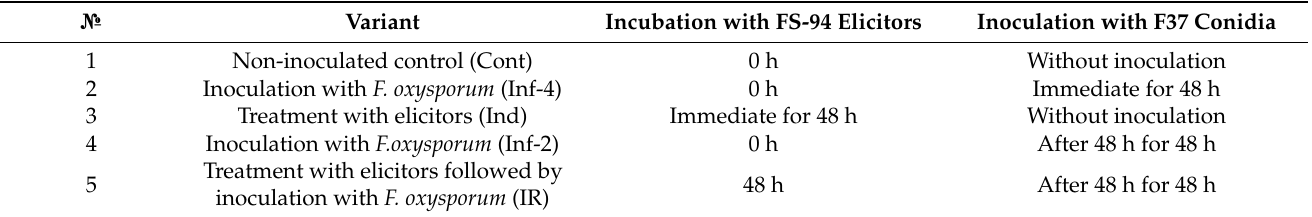
Table 2. Scheme of the